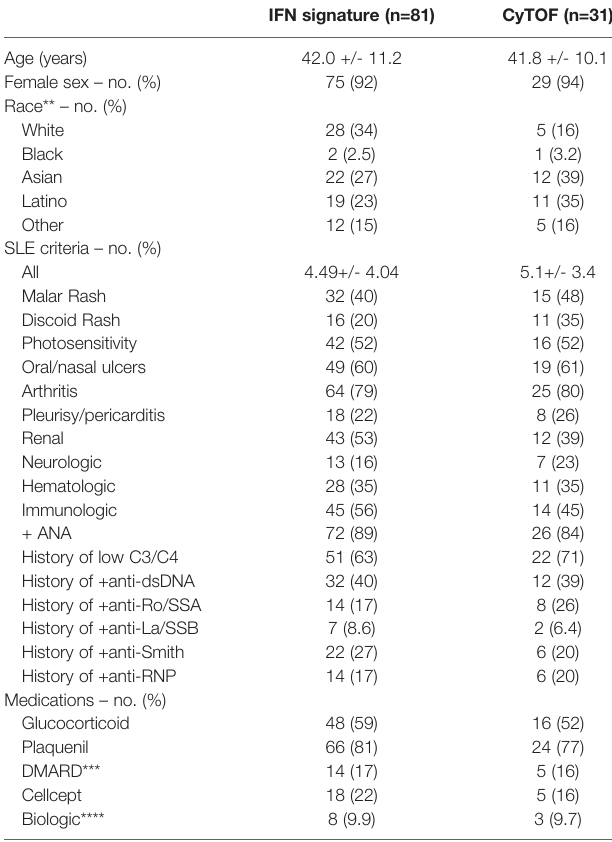
TABLE 1 | Demographic and Patient characteristics of the patients*.